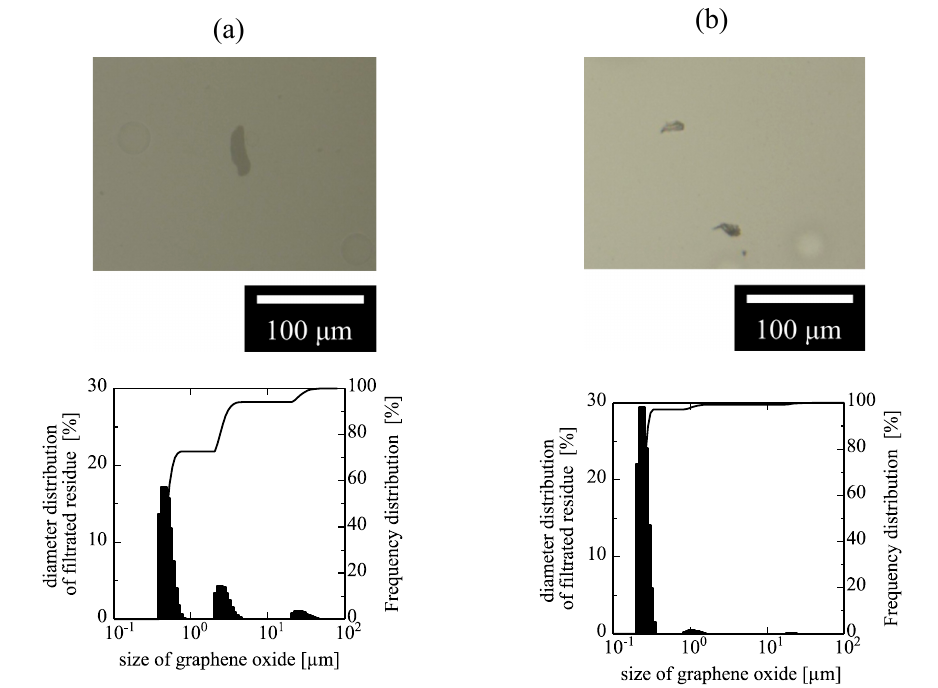
Figure 5. Optical microscope images and size distribution of recovered graphene oxide measured by dynamic light scattering by the cross flow at flow rates of ( a ) 170 mL/h and ( b ) 320 mL/h.